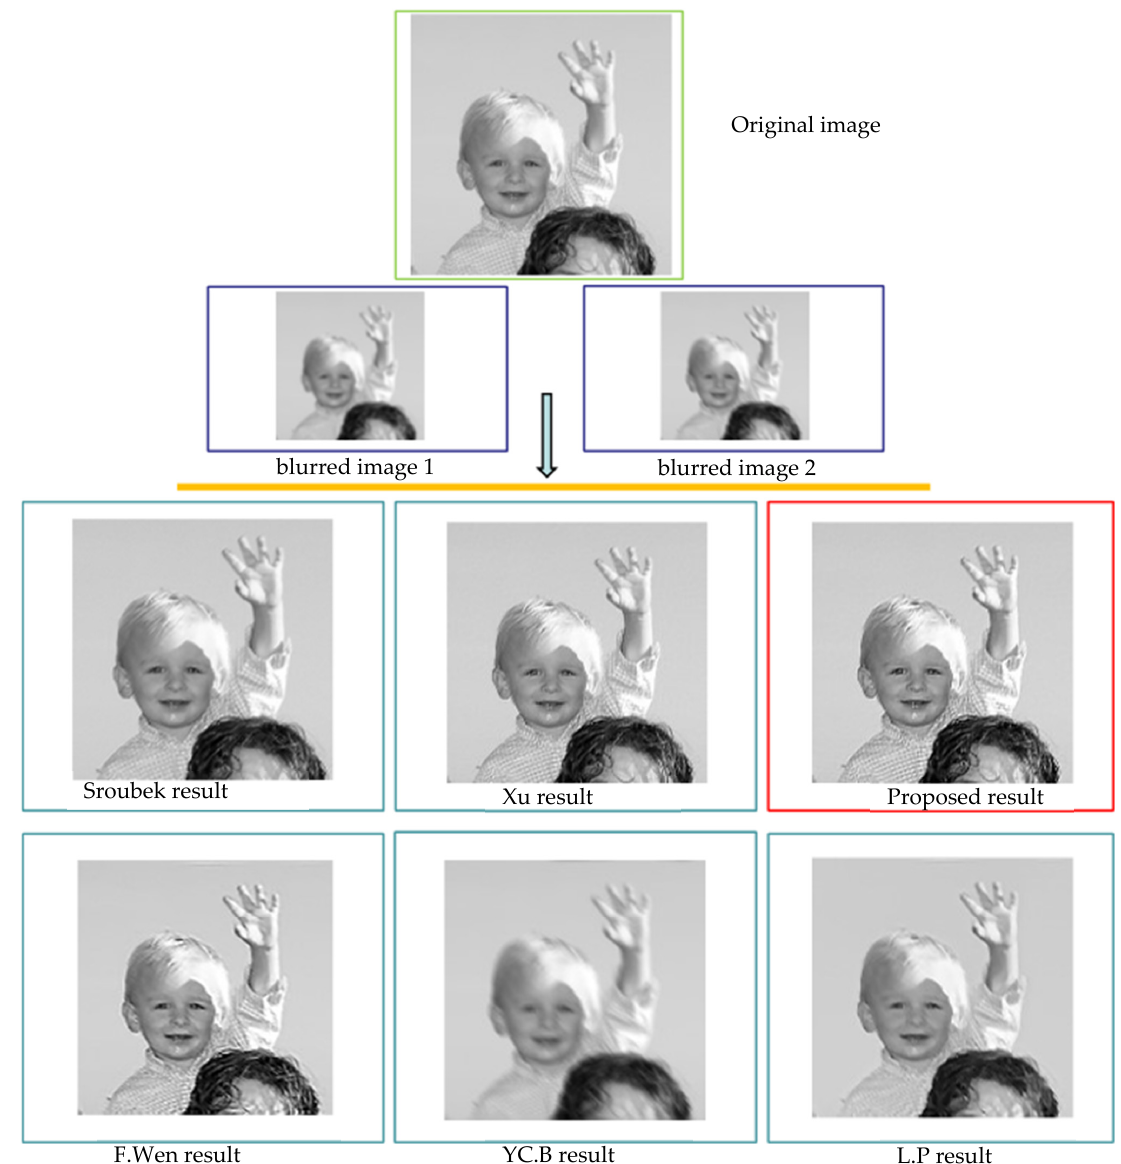
Figure 7. Sroubek’s sample restored experiment set 2. In the top line, it is the original image; the second line shows the input blurred images 1 and 2; the third line, from the left to right, are the results of Sroubek, Xu, and the proposed method; the fourth line, from the left to right, are the results of F.Wen, YC.B, and L.P.